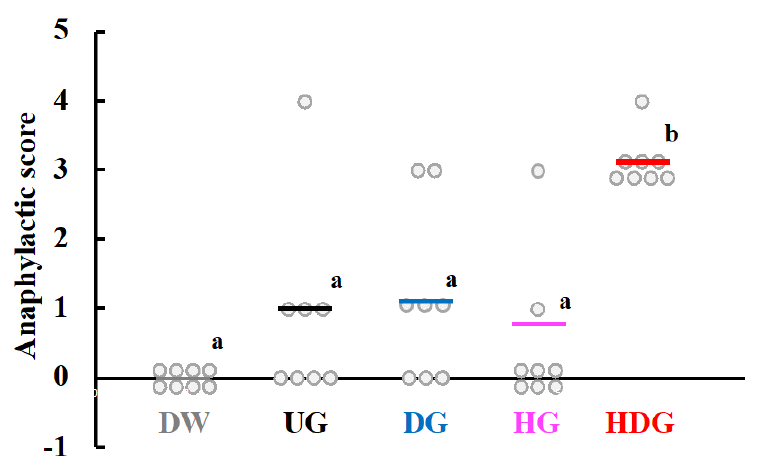
Figure 5. Anaphylactic scores of mice after intraperitoneal challenge of gliadin followed by cutaneous sensitization with the corresponding gliadin. Values with different letters are significantly different at p < 0.05 based on the Tukey–Kramer test. The bars represent the average score for each group (n = 8).